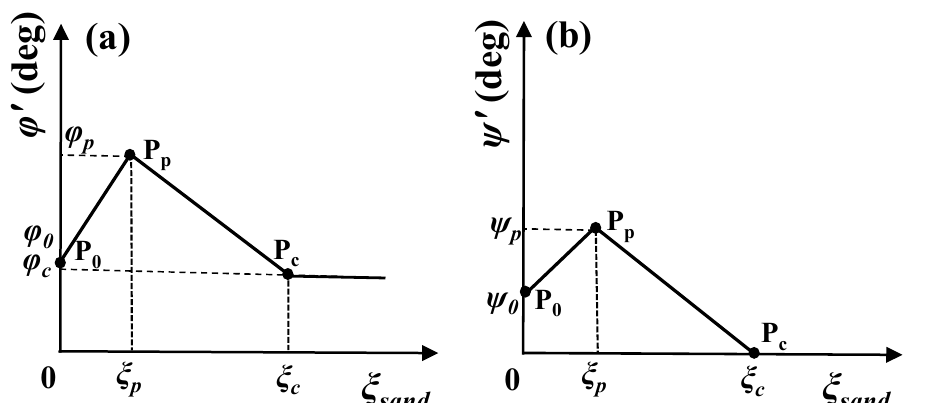
Figure 3. Variation of the friction and dilation angles of the modified Mohr–Coulomb model: ( a ) variation of friction angle; ( b ) variation of dilation angle.